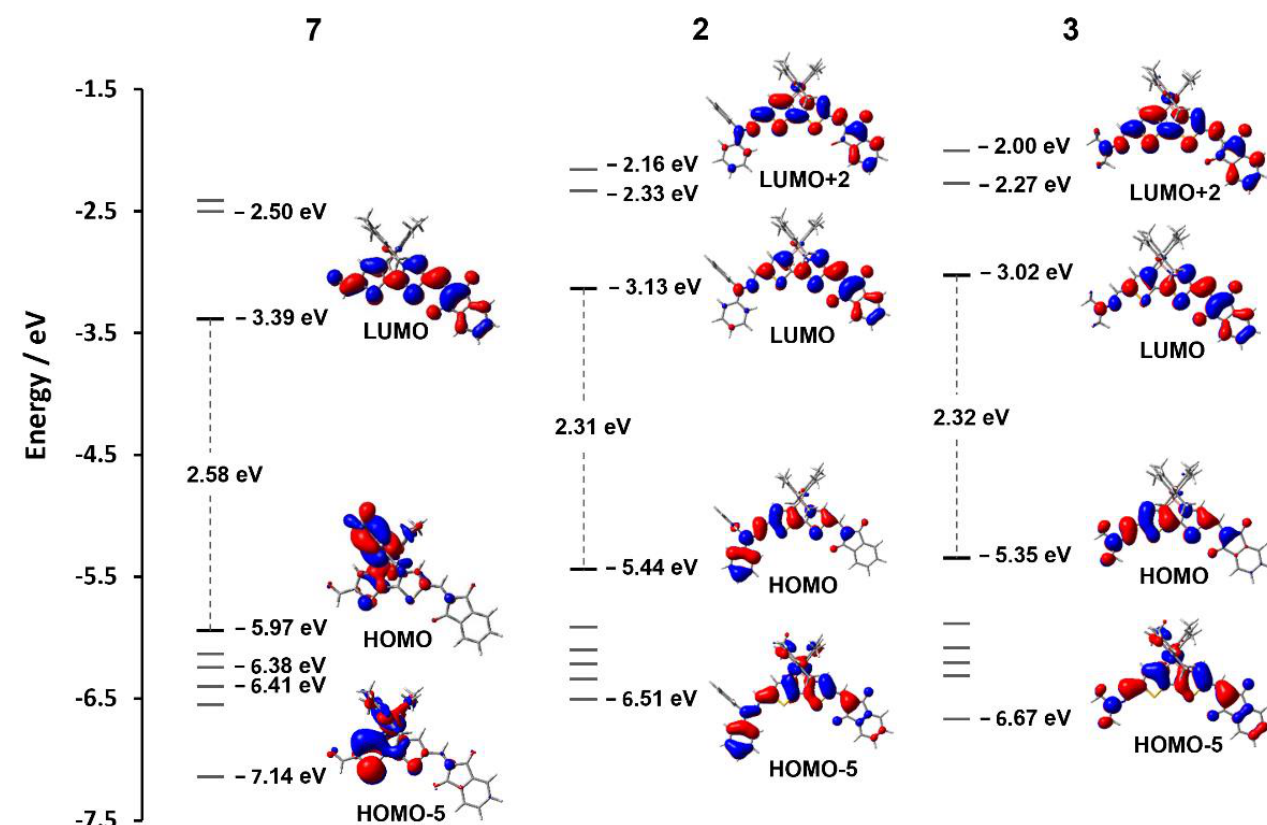
Figure 6. Kohn–Sham orbital energy level diagram (B3LYP-D3(BJ)/def2-SVP, CH 2 Cl 2 , PCM) for Figure 6. Kohn – Sham orbital energy level diagram (B3LYP-D3(BJ)/def2-SVP, CH 2 Cl 2 , PCM) for compounds 7 , 2 and 3 compounds 7 , 2 and 3 .